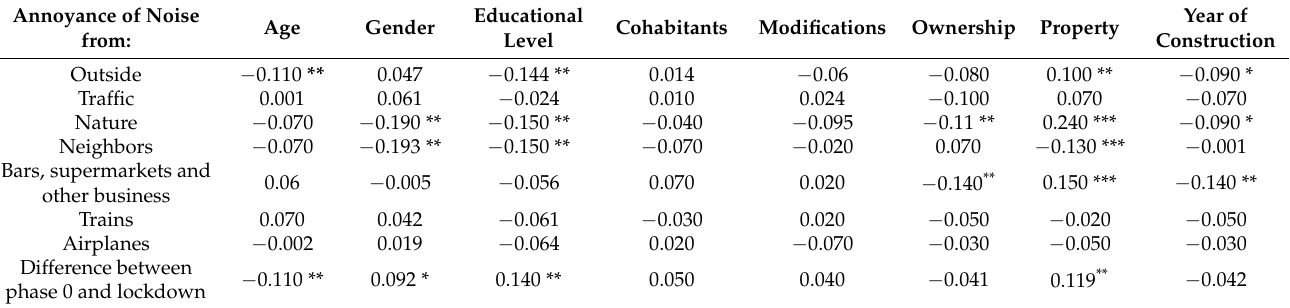
Table 3. Correlations of the sociodemographic data and noise annoyance during lockdown.